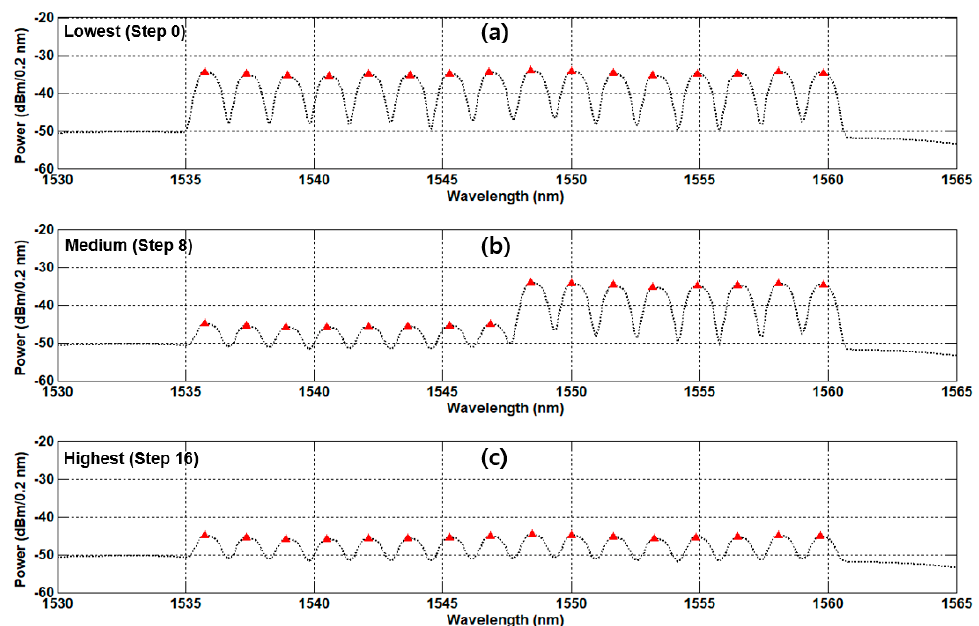
Figure 7. Measured optical spectra with a peak power detection algorithm according to the water level in the back-to-back condition: ( a ) lowest water level, ( b ) 1/2 water level, and ( c ) full water level. The solid red triangles represent the detected peak power of each SU channel.